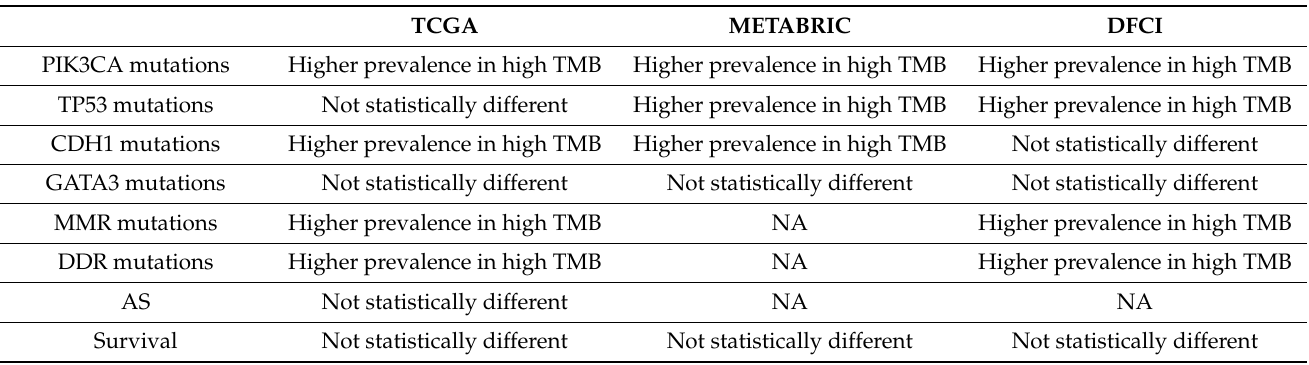
Table 7. Key characteristics and results of the ER-positive/HER2-negative/luminal breast cancer patients in the 3 series included in the current analysis. NA—not